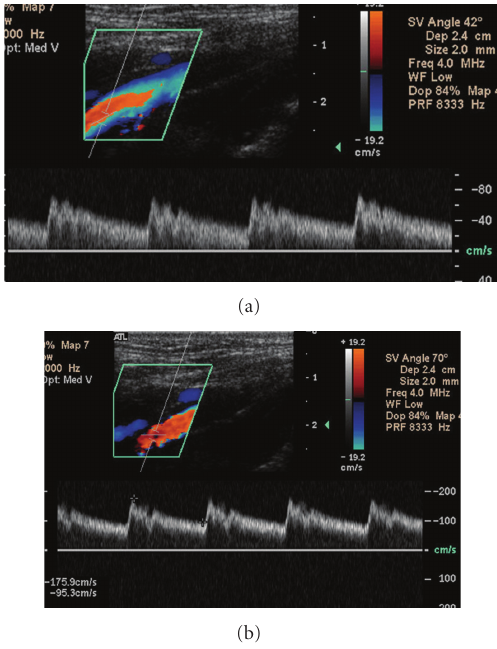
Figure 1: (a) The angle of insonation, noted by the phrase “SV Angle” in the upper left hand corner, has been set at 42 ◦ . The peak systolic velocity (PSV), the highest point at the top of the waveform, is nearly 80cm/sec. (b) The same vessel is examined now at an angle of 70 ◦ . Marking the highest and lowest points along the waveforms instructs the machine to calculate PSV and the end diastolic velocity (EDV), shown in the lower left hand corner. Using this incorrect angle, the PSV has more than doubled to 175.9 cm/sec. Great care must be taken to avoid this error as PSV is widely used as a diagnostic measure. An improper angle of insonation may thus result in a false impression of stenosis where none actually exists.